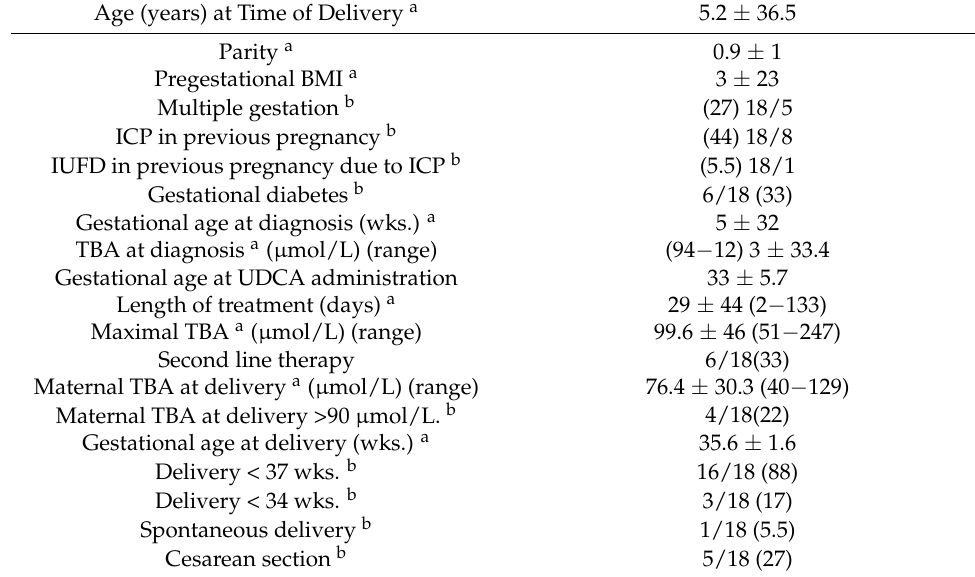
Table 1. The maternal demographics and